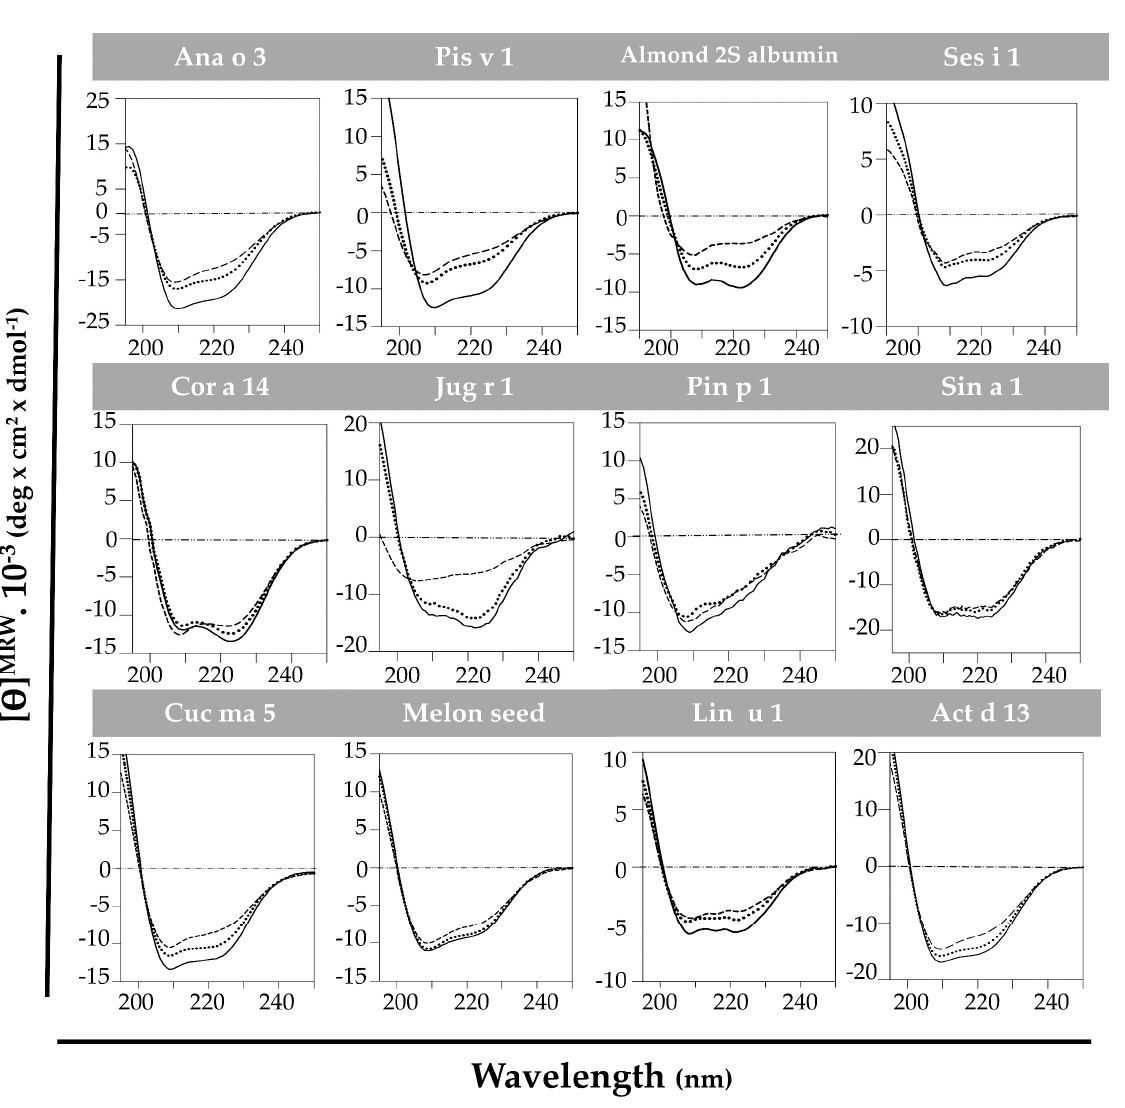
Figure 3. Spectroscopic characterization by circular dichroism at far-UV of 2S albumins. Spectra were measured at 20 °C (—), at 85 °C (----) and cooling down again at 20 °C (····). When cooling back to 20 °C, only Cor a 14 and Act d 13 completely recovered their markable that Jug r 1 was able to denature and completely renature after heat treatment.